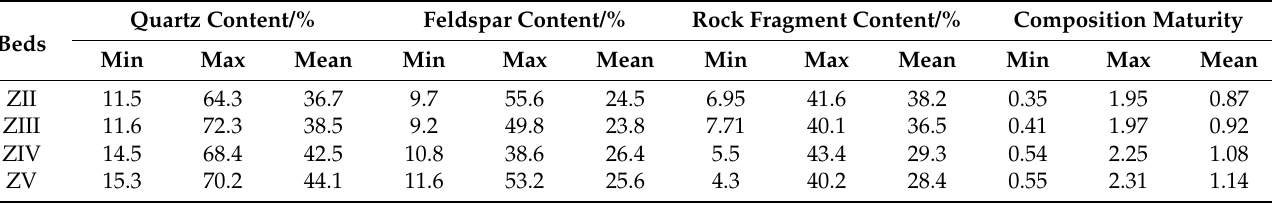
Table 1. Detrital composition of Ek1 member in the Wang Guantun Area.